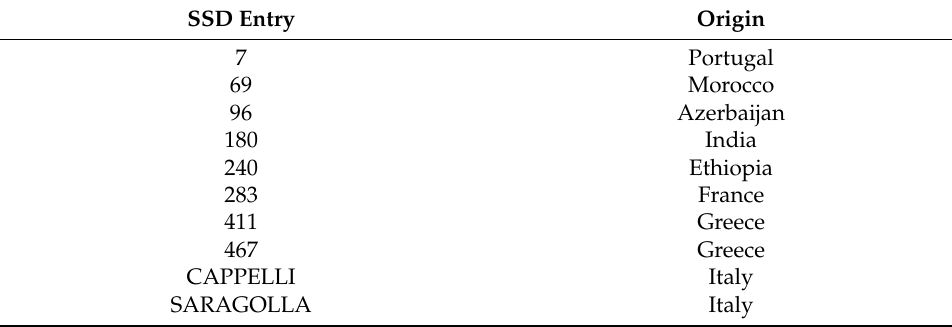
Table 1. SSD entry names and origins of the durum wheat